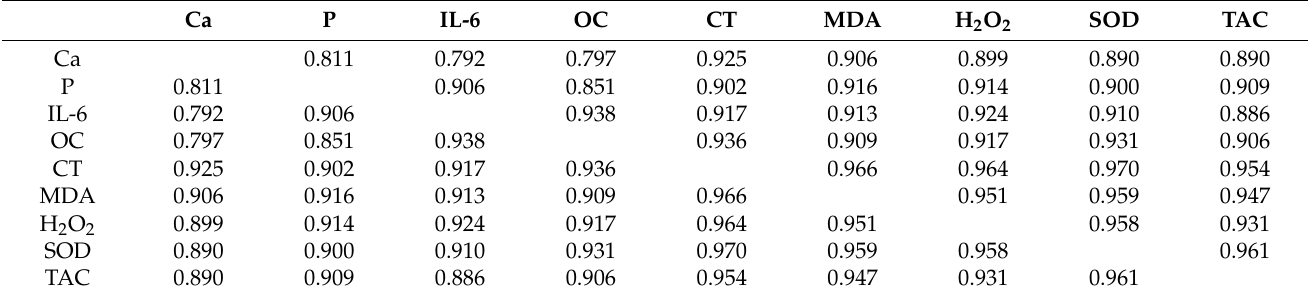
Table 3. Correlation coefficient (r) values for some measured parameters in all groups